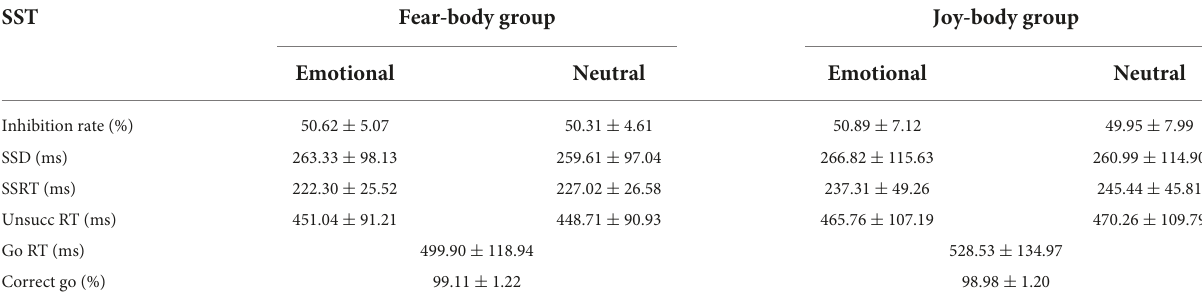
TABLE 1 Stop signal task (SST) behavioral data.